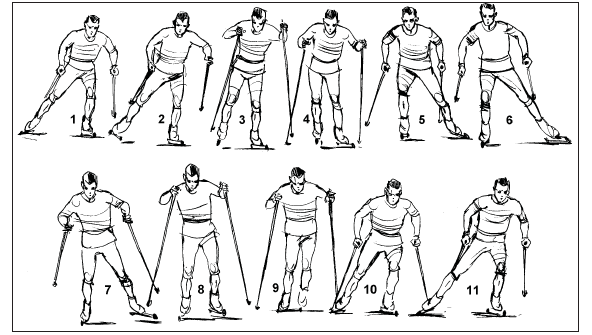
Figure 5. Timing of the monitored muscles (on roller